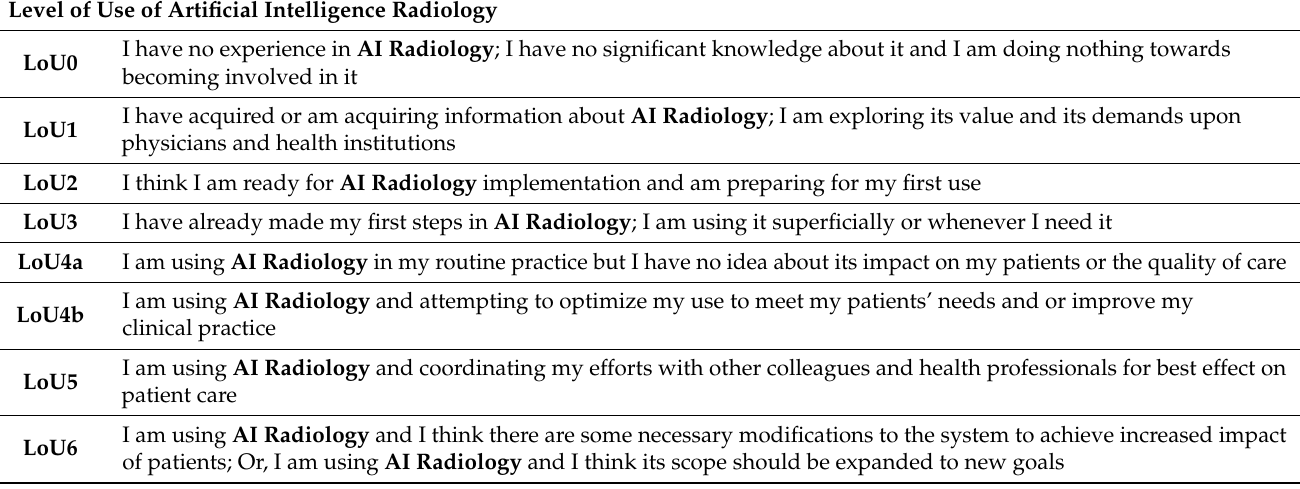
Table A1. Level of use of Artificial Intelligence in Radiology.